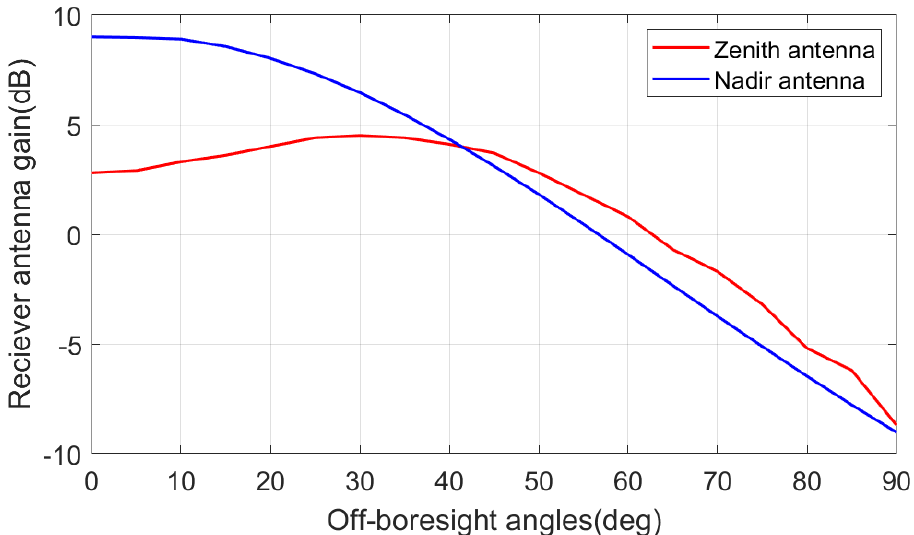
Figure 5. Receiver antenna gain with off-boresight angles.